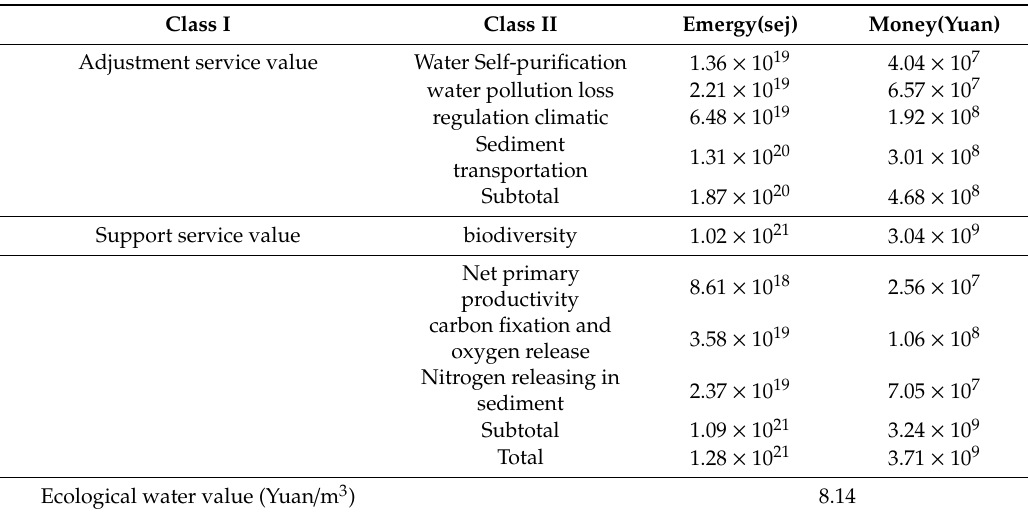
Table 6. Ecological service value of Jiyuan.